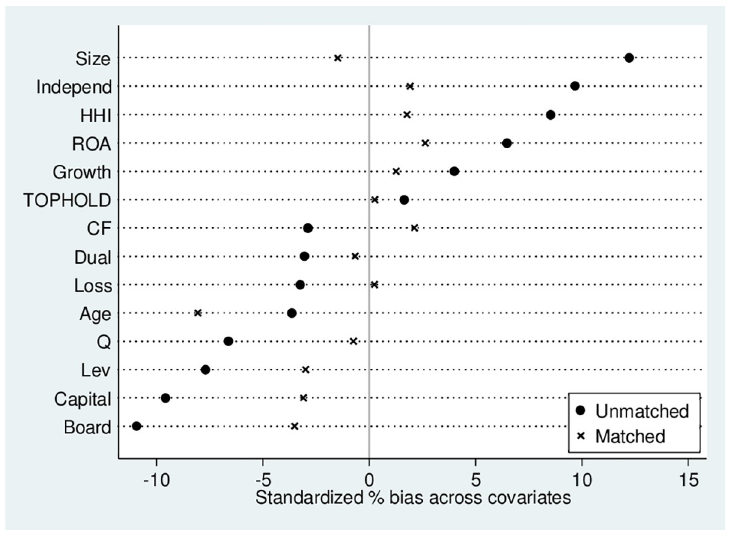
Fig 2. The comparison of the difference of covariates before and after matching.